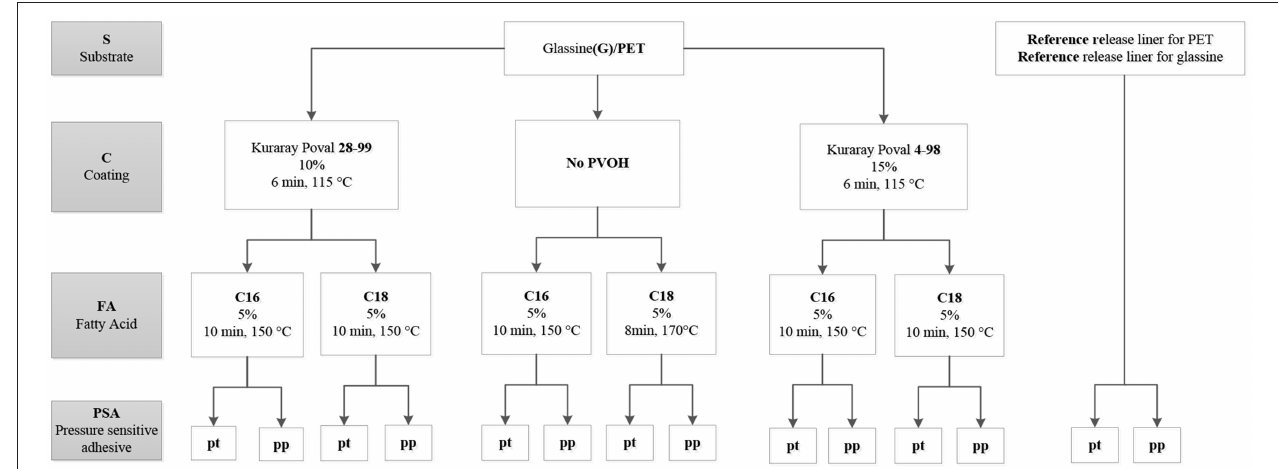
FIGURE 3 | Experimental design. Letters in bold are the abbreviations used